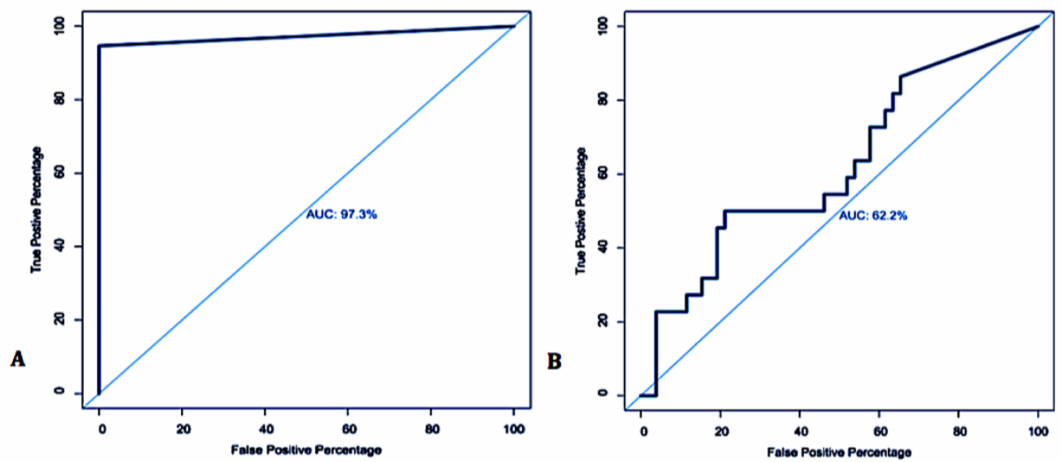
Figure 1. Receiver operating characteristic (ROC) curve analysis and corresponding area under the curve (AUC) analysis of the MqPCR dataset when the reference models were adjusted based on MqPCR and MELISA ( A ) and MELISA ( B ), respectively.